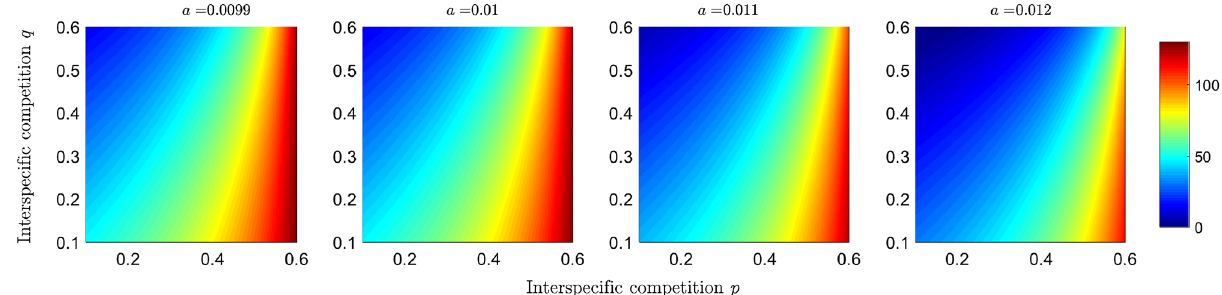
Figure 6. Simulation of the infected subpopulation of the prey at equilibrium as a function of the competition parameters p and q under different scenarios of predation efficiency a , where ( q , p ) ∈ [ 0.1, 0.6 ] × [ 0.1, 0.6 ] . The colored bar represents the number of infected